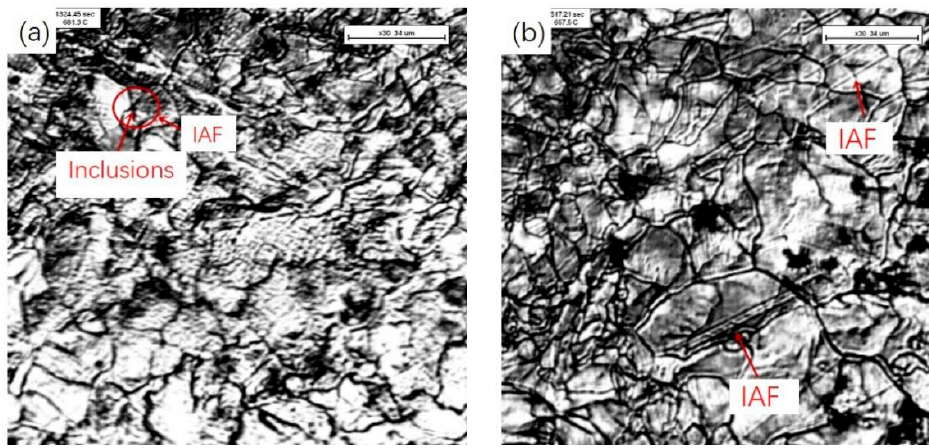
Figure 17. Observation of intragranular acicular ferrite (IAF) in industrial test steel by confocal laser scanning microscopy (CLSM): ( a ) IAF at boundaries; ( b ) IAF in austenite.